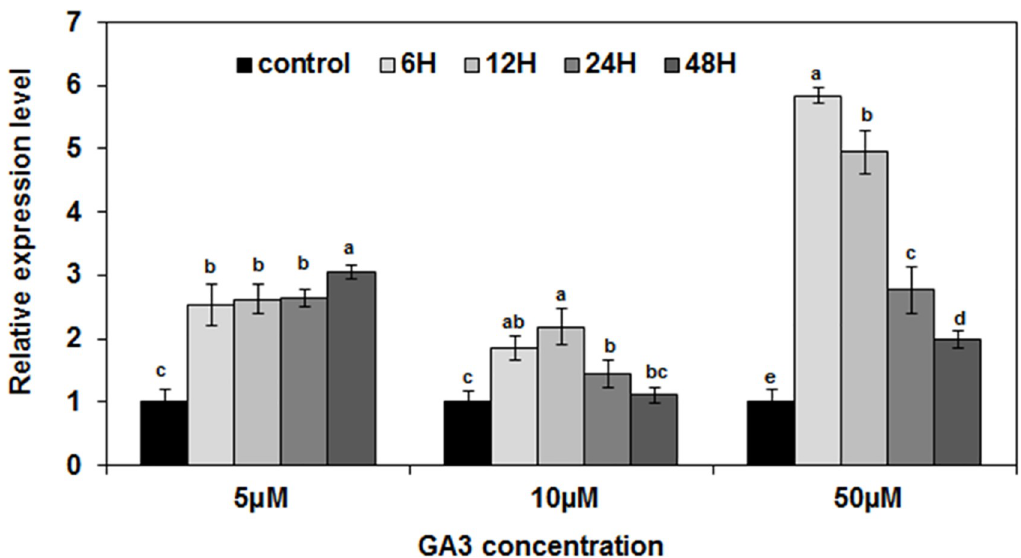
Fig 2. RT-qPCR analysis of the mRNA levels of LmSAP in L . maritime plants treated with 5, 10, or 50 μ M of GA3 for 0, 6, 12, 24 and 48 h. The data from RT-qPCR experiments were analysed by the 2 - ΔΔ CT method and are represented as means ± SE. Means denoted by the same letter were not significantly different at p <